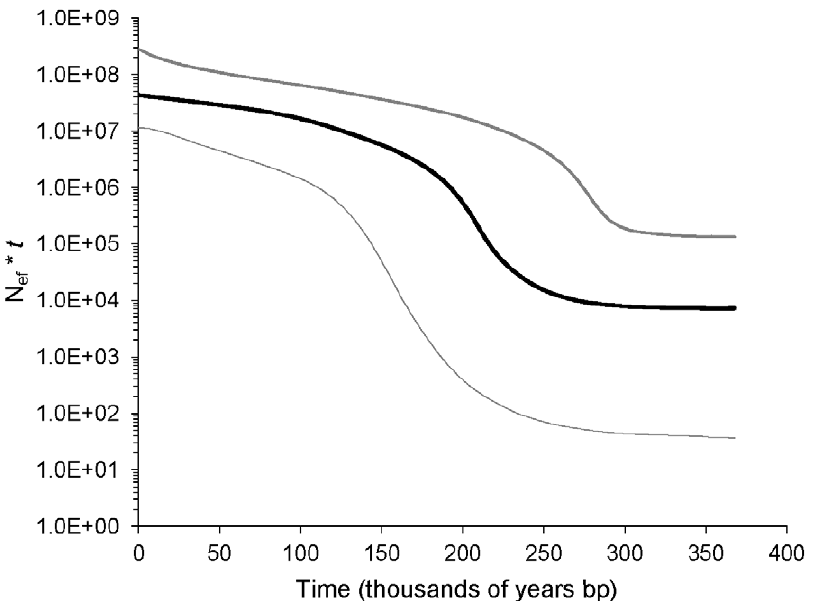
Figure 3. Bayesian skyline plot for Coralliophilaabbreviata derived from mitochondrial cytochrome b sequence data. The solid black line represents the median female effective population size ( N ef ) multiplied by the generation time ( t ), plotted on a log scale. The thin grey lines are the upper and lower 95% highest posterior distribution (HPD) for the population size estimator.